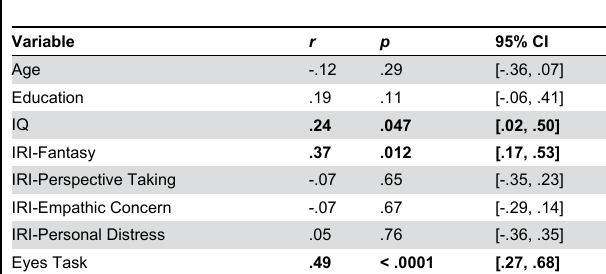
Table 2. Relationship Between Mental State Reasoning Score, Demographic Variables, IQ, and Social